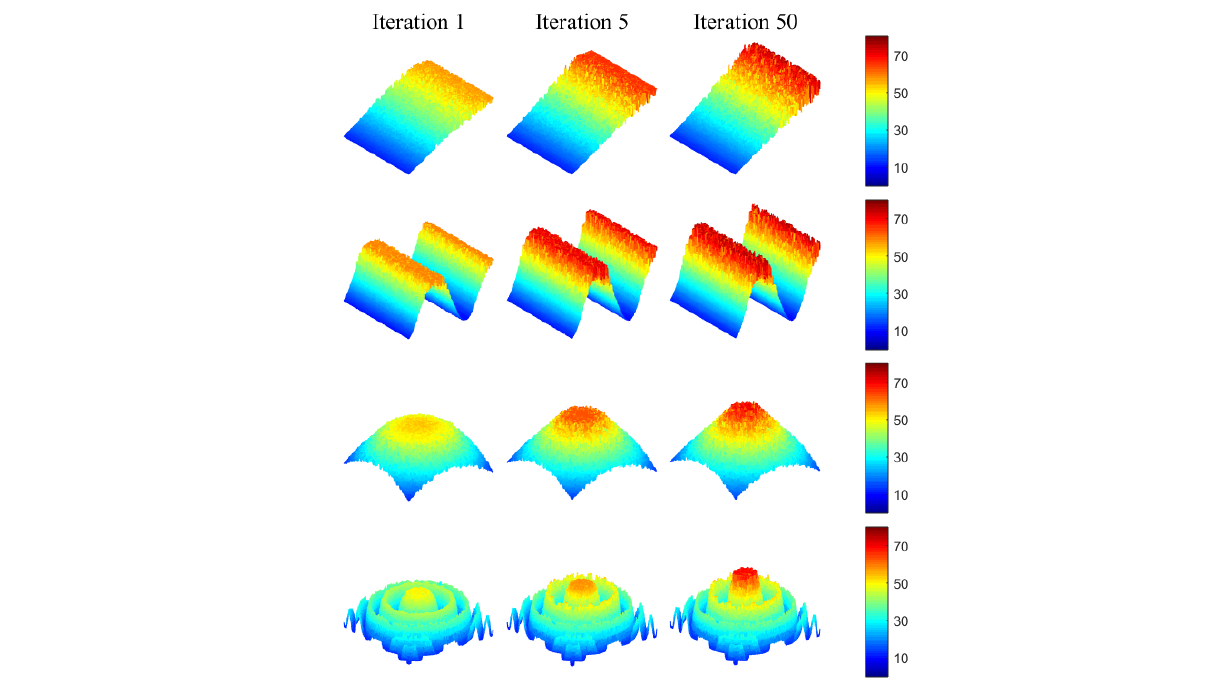
Figure 8. Restored three-dimensional (3D) depth maps for synthetic objects with different learning iterations, first row: plane object, second row: sinusoidal object, third row: cone object, and fourth row: wave object. In addition, first column: Iteration 1, second column: Iteration 5, and third column: Iteration 50. In this experiment, the Planar model with WP method is utilized for measuring depth